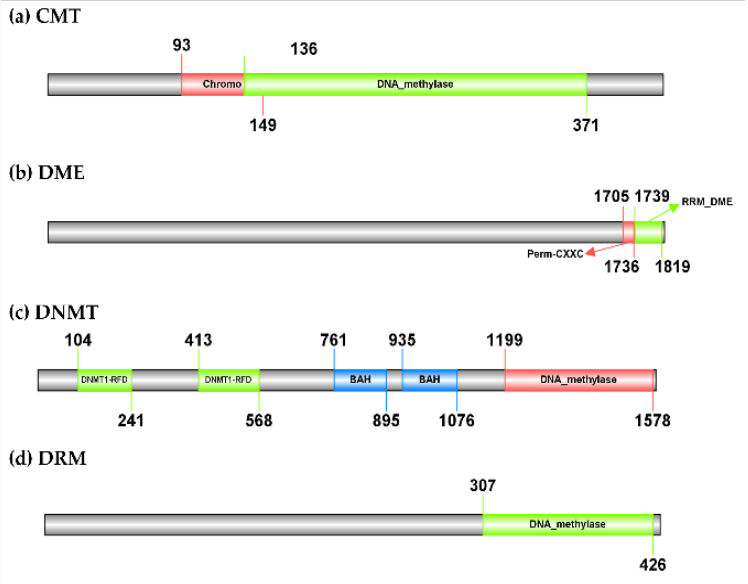
Figure 2. Organisation of the domains of the three identified DNA methylases and one demethylase in Humulus lupulus . A typical C-5 cytosine-specific DNA methylase domain (PF00145) was found in CMT, DNMT, and DRM genes. In addition, CMT contains one (CHRromatin Organization MOdifier) domain (PF00385) and DNMT contains two consecutive cytosine-specific DNA methyltransferase replication foci domains (PF12047), before the two BAH domains (PF01426). The DME gene consists of two domains, an RRM in demeter (PF15628) involved in the release of methyl groups from DNA and a permuted single zf-CXXC unit (PF15629). The online tool Illustrator of Biological Sequences (IBS; http://ibs.biocuckoo.org/online.php; accessed on 8 March 2022) was used to visualize the protein